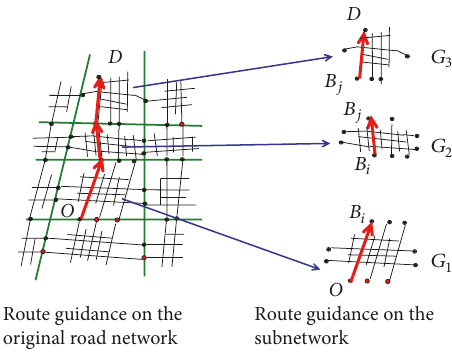
Figure 3: An example of decomposition of route guidance. where 𝜏 𝑚𝑎𝑥 , 𝛼, 𝛽 are constants; 𝑁𝑉 is the total number of vehicles in the road network.